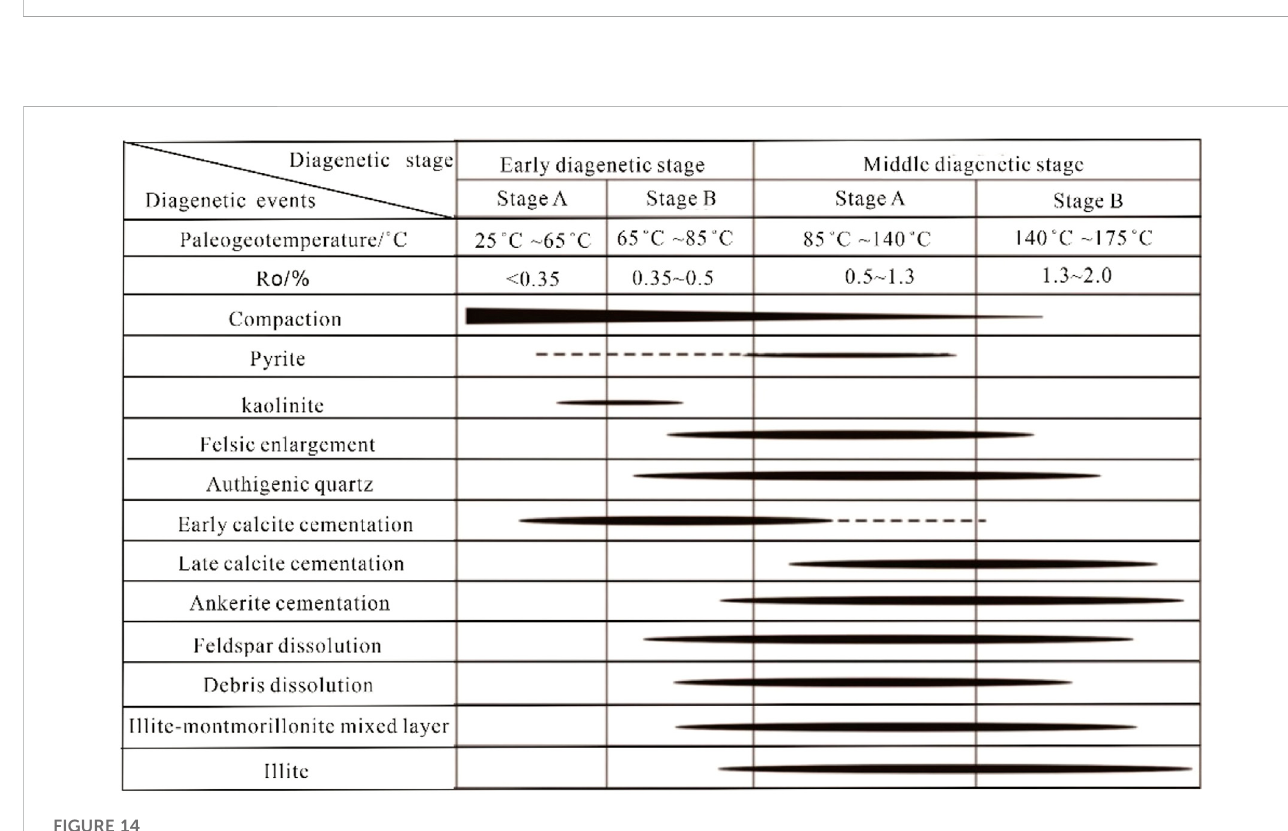
Frontiers in Earth